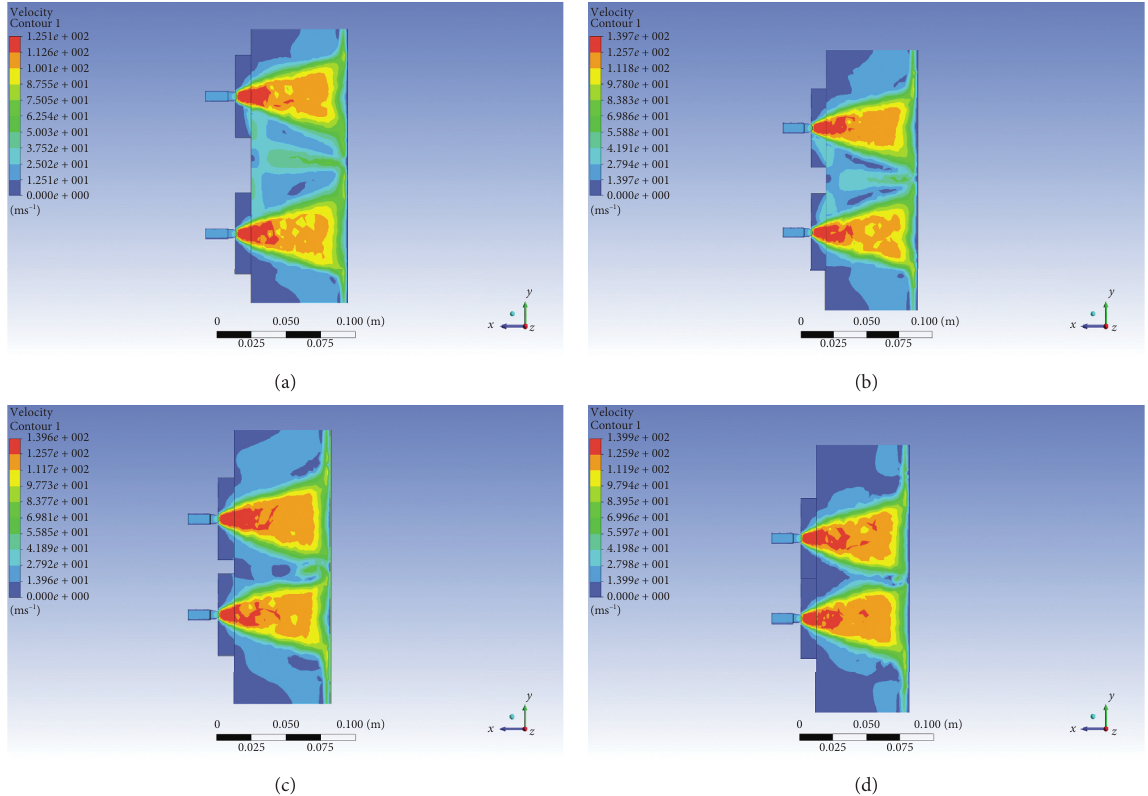
Figure 17: Velocity nephogram with different spacing. (a) 100mm. (b) 80 mm. (c) 70mm. (d) 60mm.